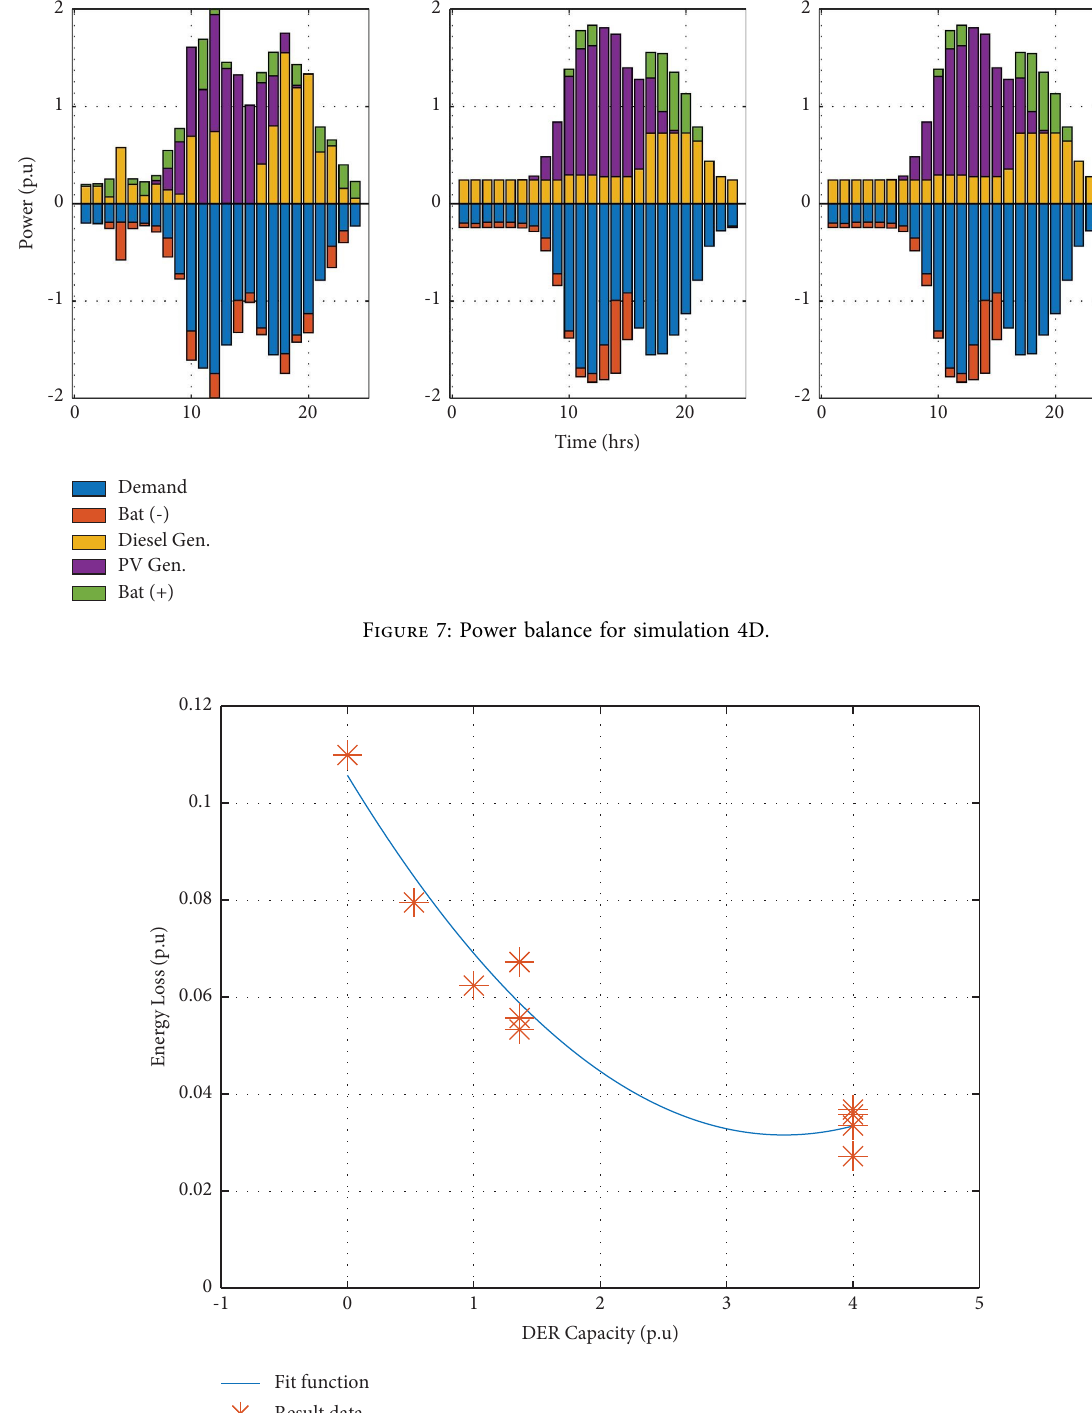
Figure 8: Energy loss plot versus DER